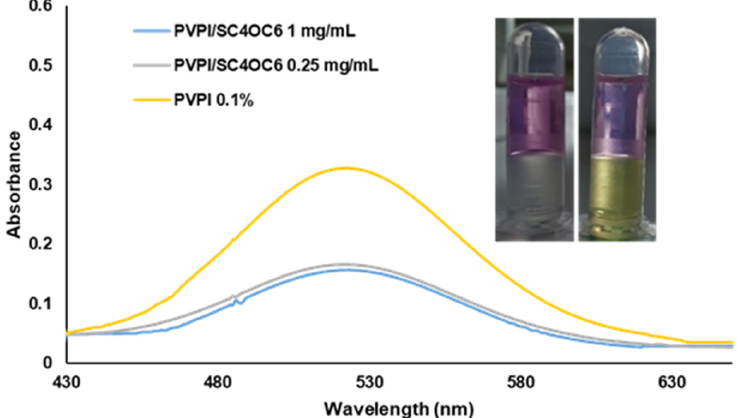
Figure 9. UV-vis spectra of iodine in cyclohexane (10 s shaking) from PVPI alone and with different amounts of SC4OC6; inset: pictures of the iodine extraction from a solution of 0.1% PVPI (left) and PVPI/SC4OC6